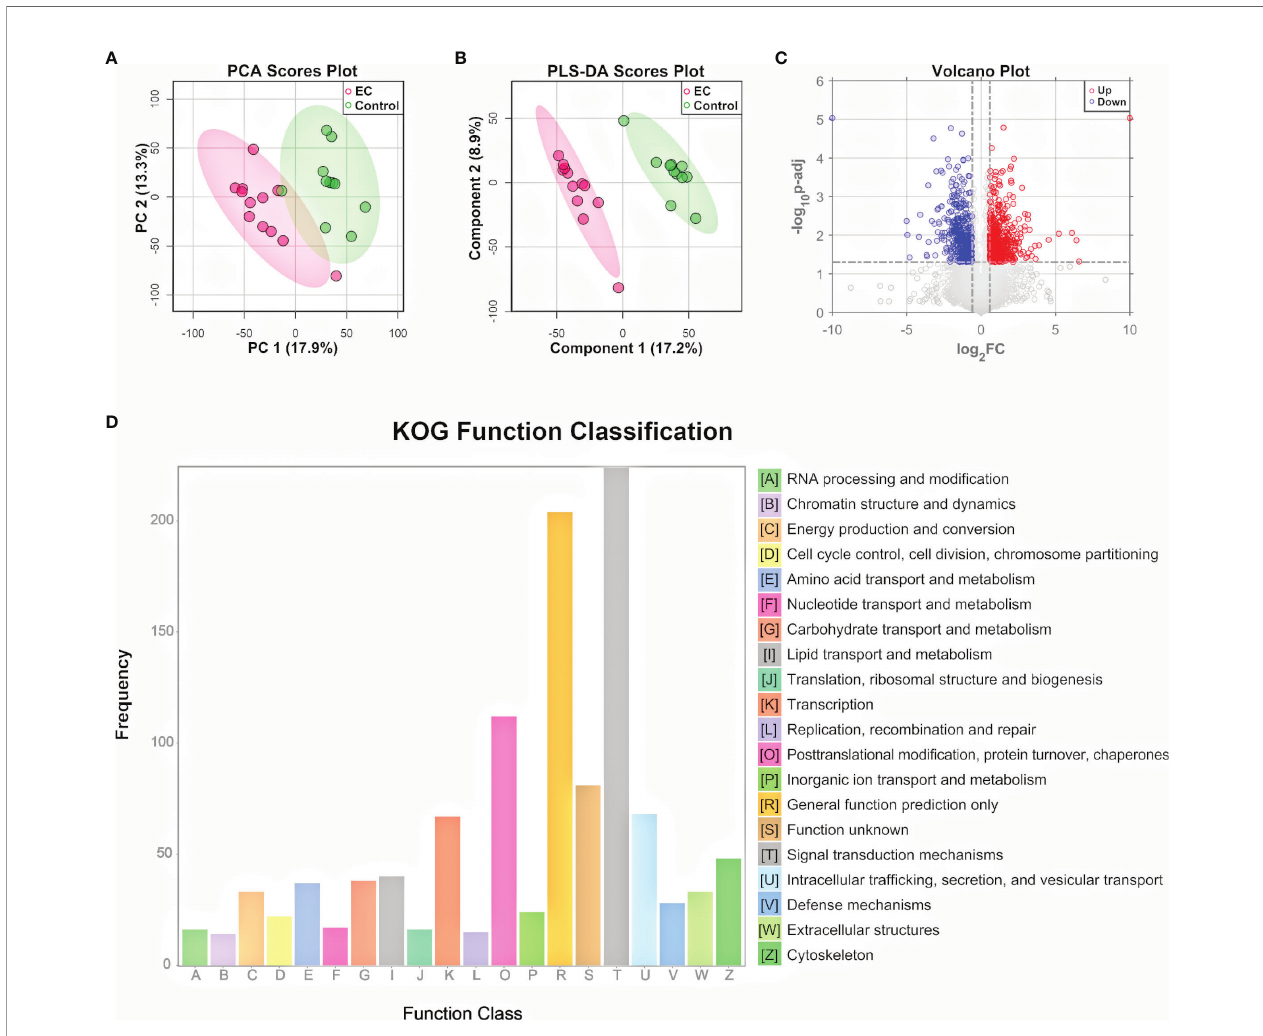
FIGURE 3 | Proteomic analysis of EC tissue samples. (A) PCA and (B) PLS-DA score plot for proteomic data of tissue samples from EC and control groups by LC- MS/MS in the positive ion mode. (C) Volcano plots of proteins with log 2 (FC) as the horizontal axis and − log 10 ( p -value) as the vertical axis. FC, fold change of EC to control. (D) KOG functional annotation of the 1,445 proteins with signi fi cant variations in EC tissue samples compared to